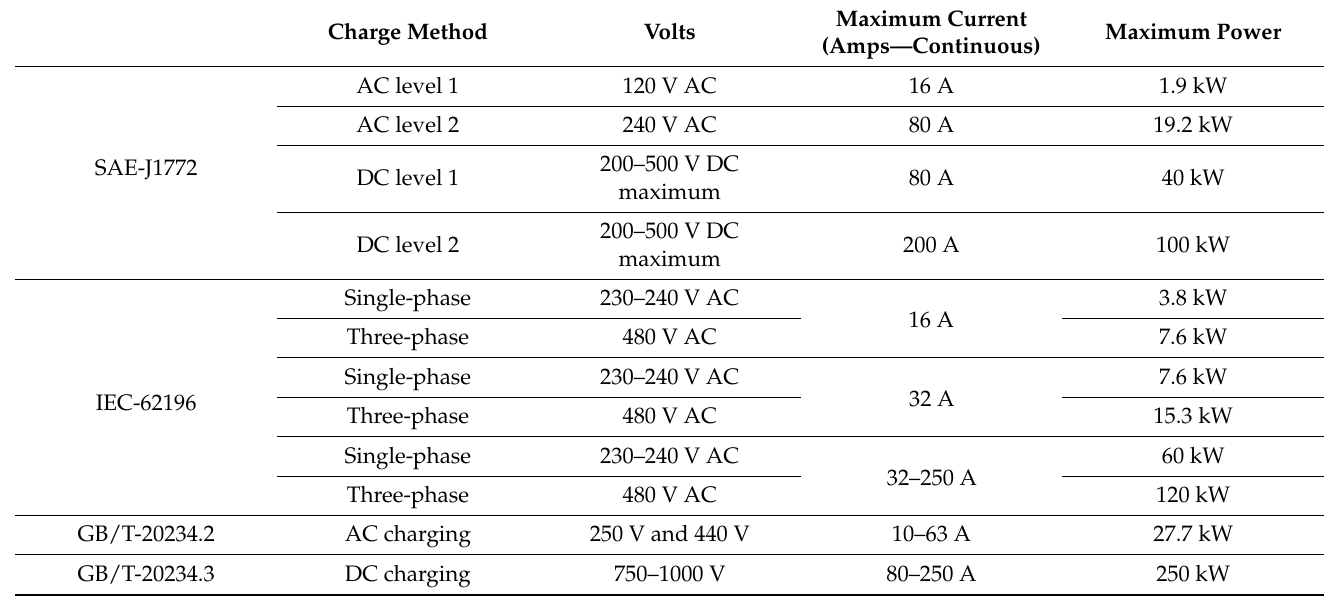
Table 3. Standard charging power ratings of various conductive Charging standards for EV applications.